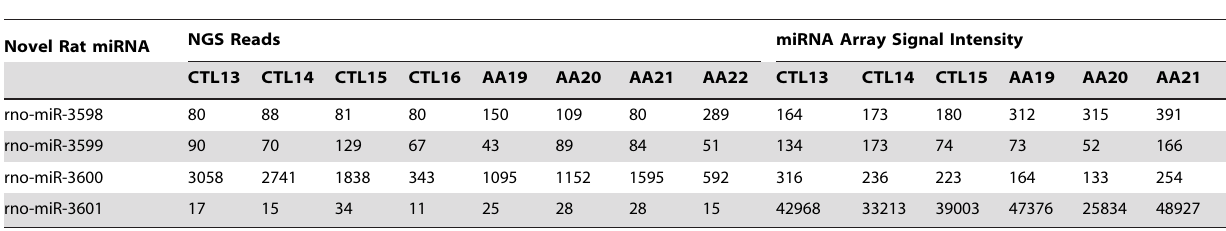
Table 6. Four rat-specific novel miRNAs - NGS read counts and microarray signal intensities.